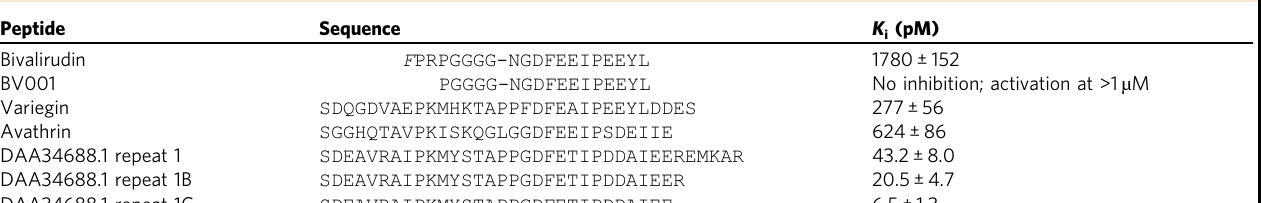
Table 1 Inhibitory constant ( K i ) of thrombin-inhibiting peptides. Peptide Sequence K i (pM) Bivalirudin F PRPGGGG-NGDFEEIPEEYL